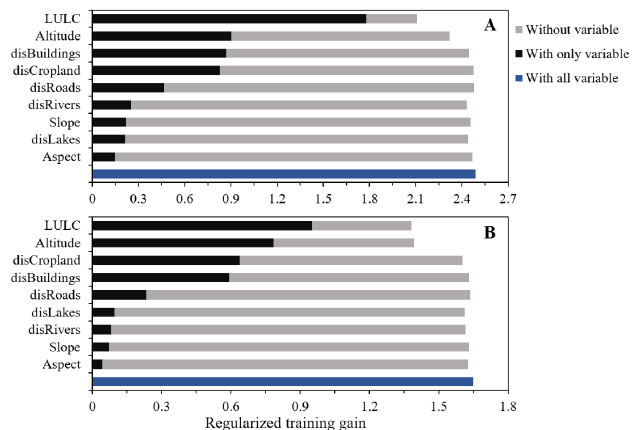
Figure A4. Regularized training gain for each variable for the blood pheasant ( A ) and the blue eared pheasant ( B ).